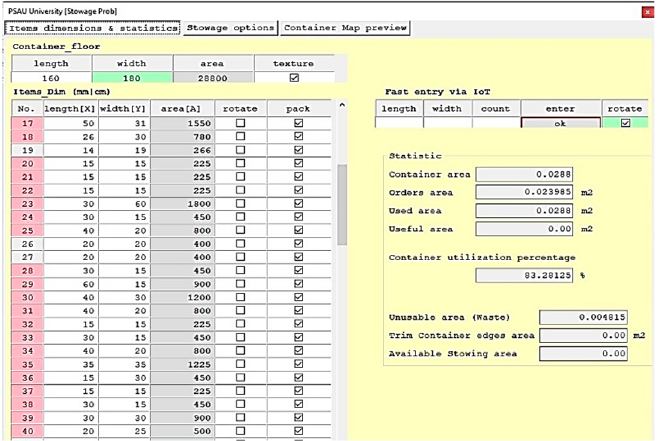
Figure A12. The container utilization by camel algorithm for third station on the distribution path.